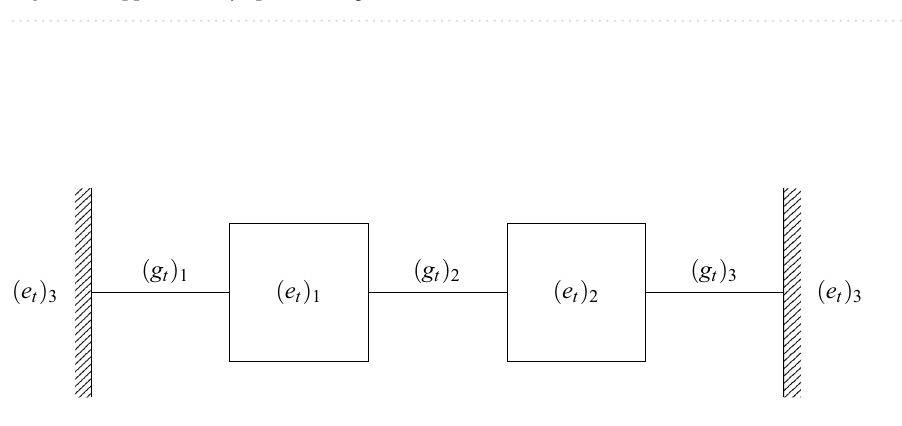
Figure 5. Graph set up for the temperature control problem. Here, ( e t ) 3 is the ambient temperature at time t , while ( e t ) 1 and ( e t ) 2 are the temperatures of rooms 1 and 2, respectively. The g t are the conductances of the indicated